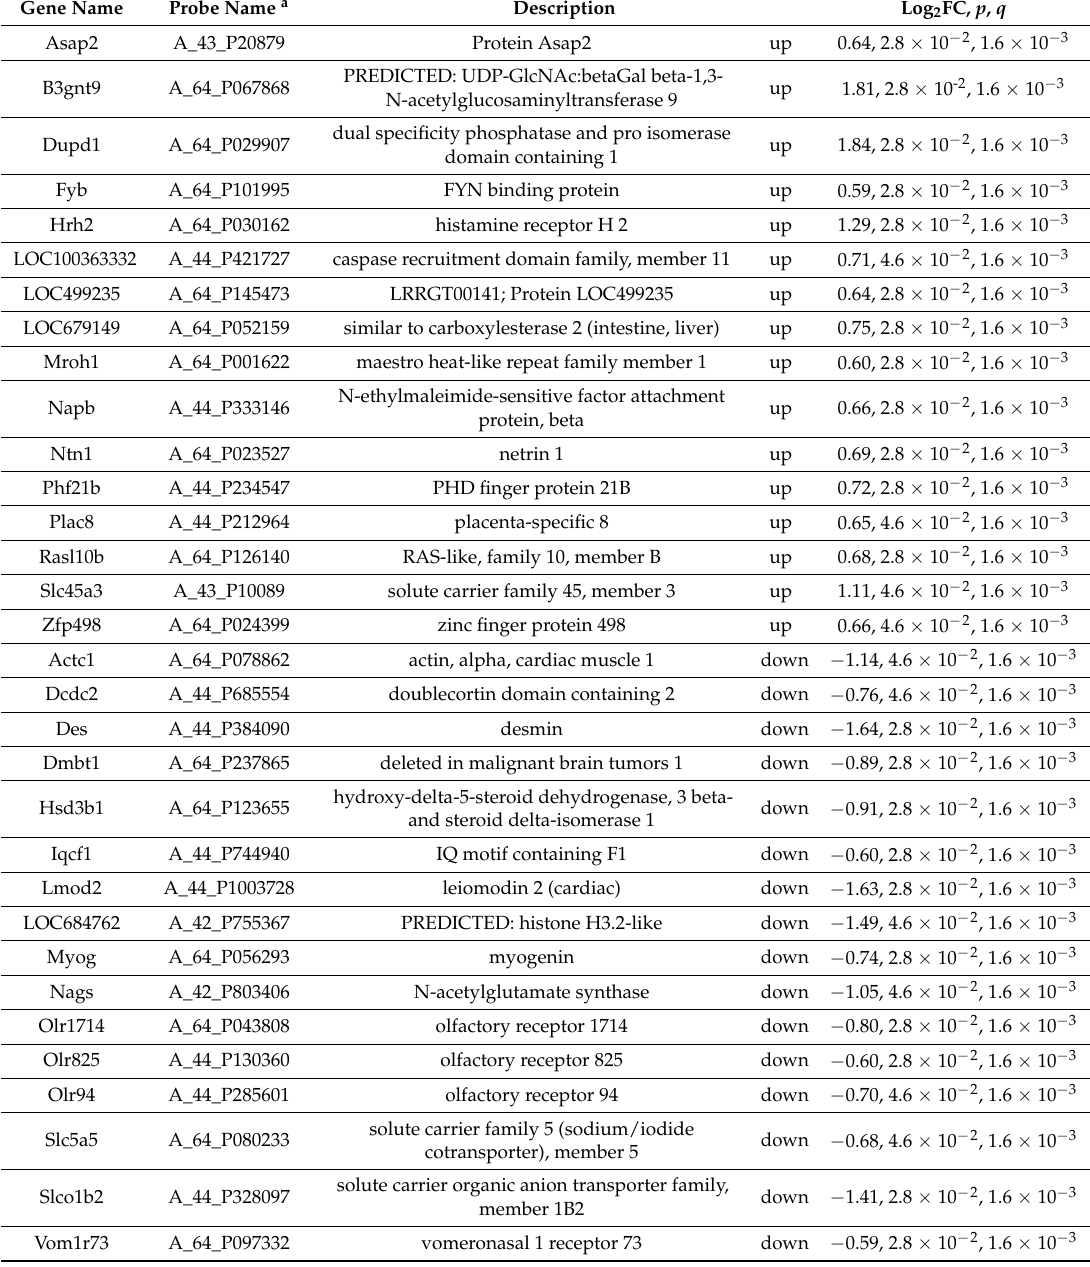
Table 3. DE genes unique to